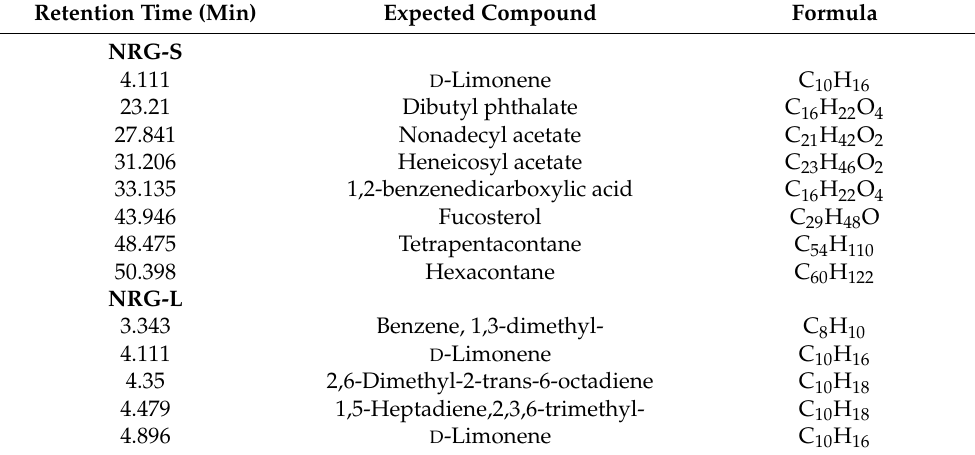
Table 2. Major compounds analyzed from GC-MS for waste NRG-S and its fraction (NRG-L). Retention Time